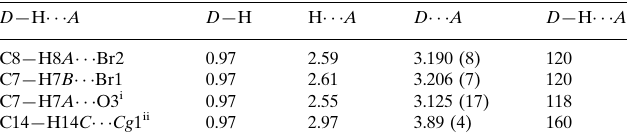
Hydrogen-bond geometry (A˚ , (cid:1)